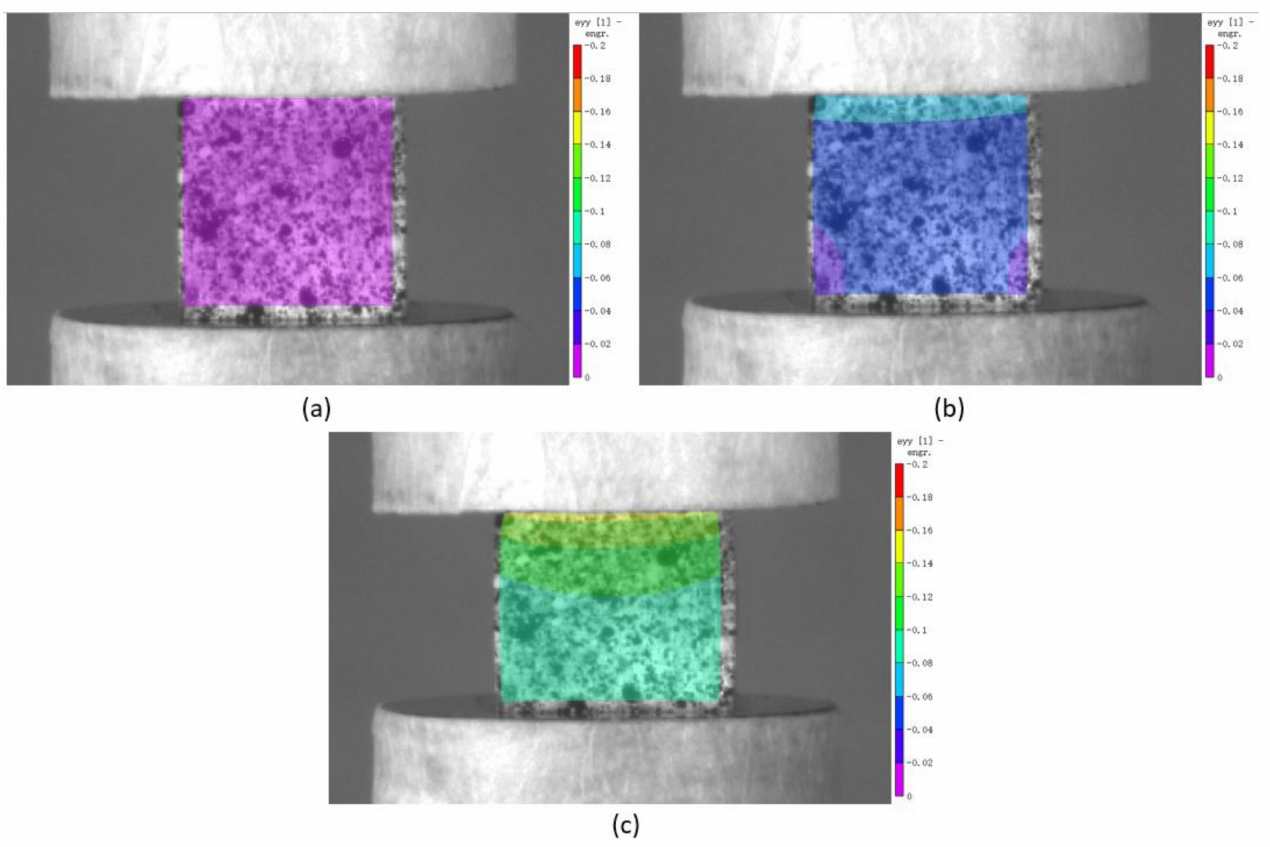
Figure 10. DIC frames of the three points marked out in the bulk dissolvable aluminum compression curve: ( a ) 34 s; ( b ) 131 s; ( c ) 228